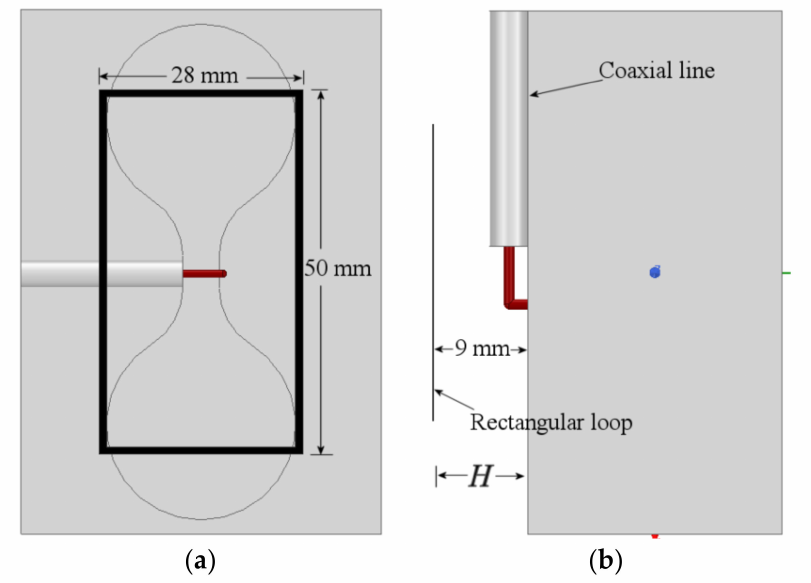
Figure 8. Rectangular loop and dumbbell slot antenna: ( a ) top-view, ( b ) side-view.